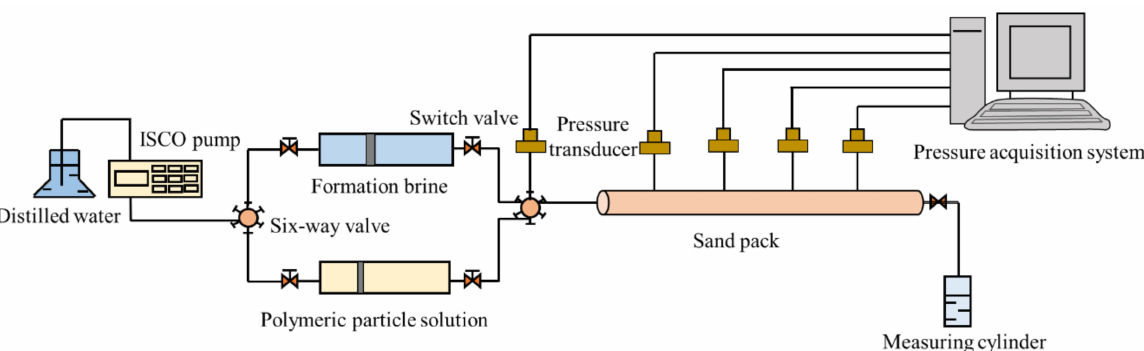
Figure 4. Schematic diagram of the profile control experiment. The experiment set-up consisted of a sand pack, a syringe pump to inject fluid at a constant flow rate, a measuring cylinder to collect the residual liquid flowing from the outlet of the sand pack, and five pressure transducers that were connected to a computer for continuous recording of the pressures at different positions of the sand